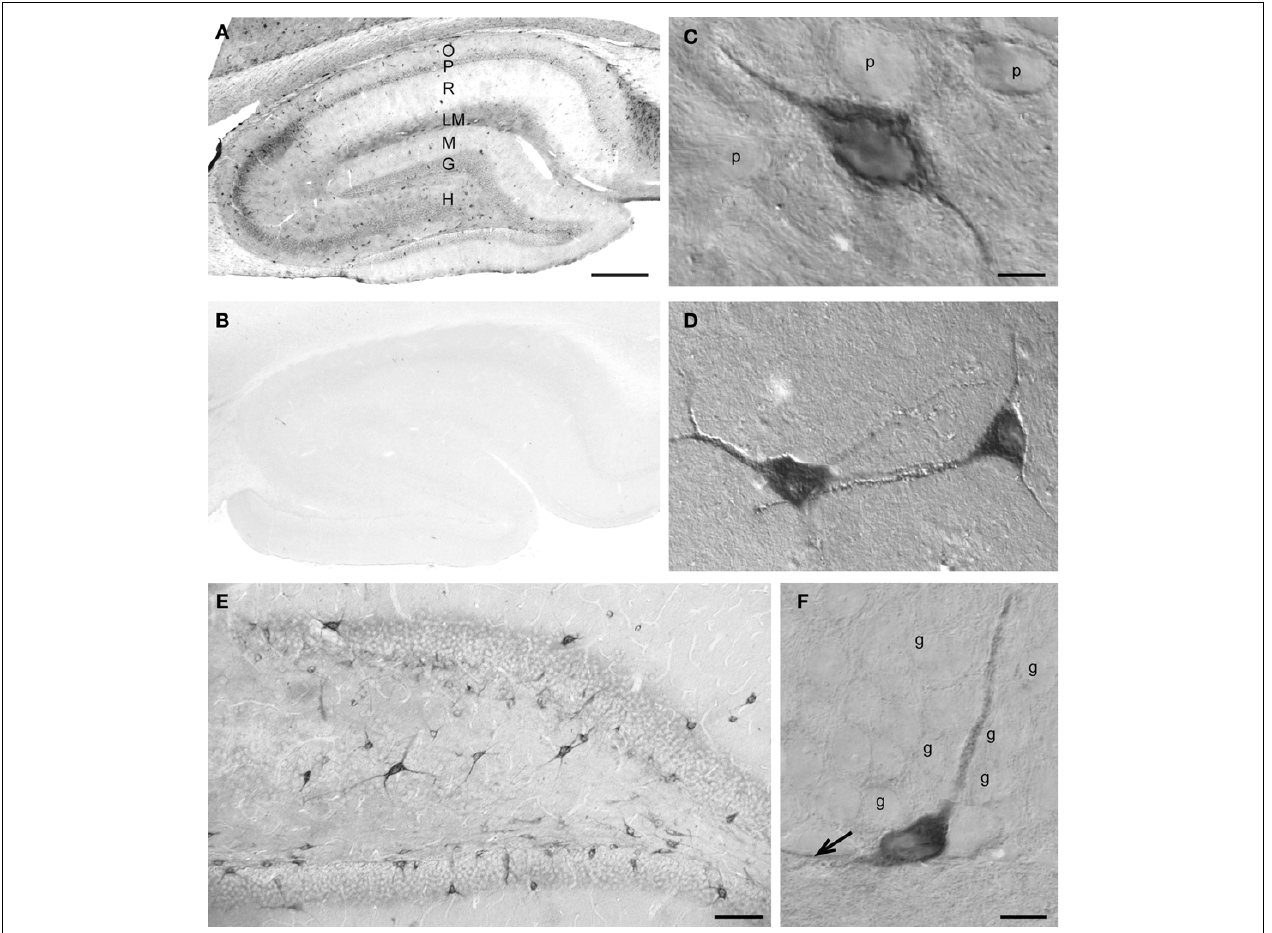
FIGURE 5 | SAT1 immunostaining is enriched in hippocampal interneurons. (A) The hippocampal formation contains dispersed cells strongly immunostained for SAT1 while the principal cells are weakly immunostained. The neuropil is moderately stained in the vicinity of the principal cells (P and G) and in stratum lacunosum-moleculare (LM). (B) SAT1 immunostaining is abolished on preincubation of SAT1 antibody with the fusion protein used for immunization. (C) High power light microscopy confi rms strong SAT1 immunostaining of non-pyramidal cells and their processes between faintly labeled pyramidal cells of CA1. Intracellular stained structures are visible. (D) Two SAT1 immunostained cells in the stratum oriens of CA1. Note that SAT1